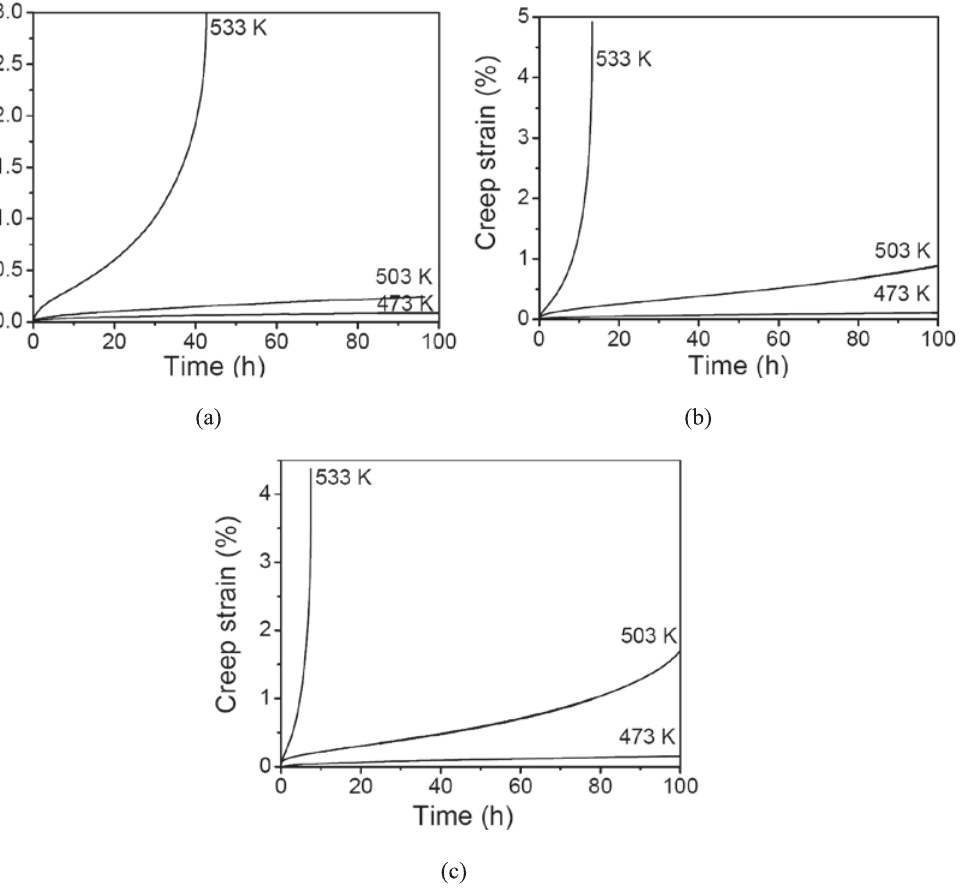
Fig. 1: Creep curves of 2124-T851 aluminum alloy obtained from constant stress uniaxial tensile creep tests at applied stresses (a) 120 MPa, (b) 140 MPa and (c) 160 MPa.